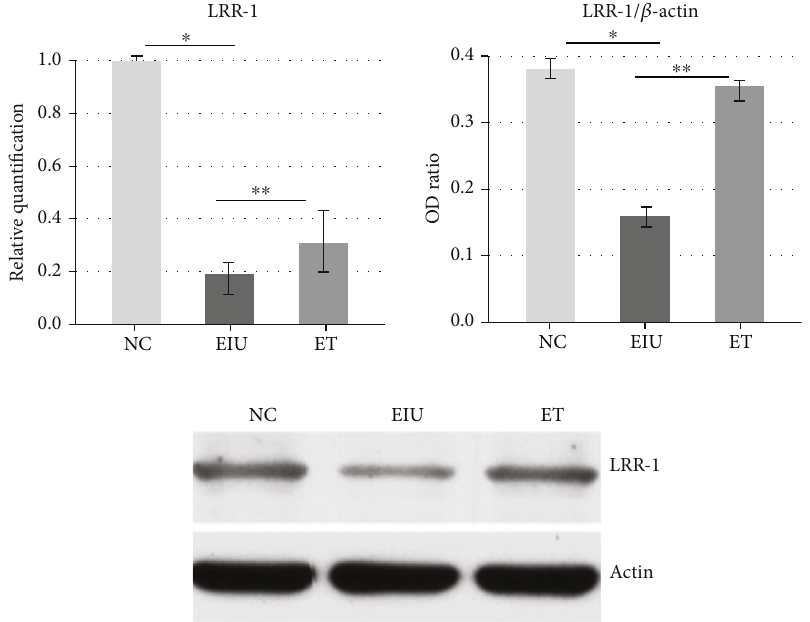
Figure 6: Real-time PCR and Western blot of LRR-1 in ICB. Both mRNA and protein expression of LRR-1 in the EIU group were lower than that in the NC group ( ∗ P < 0 : 05 ) and ET group (the mRNA expression of LRR-1: F = 348 : 862 , ∗∗ P < 0 : 05 ; the protein expression of LRR-1: F = 388 : 500 , ∗∗ P < 0 : 05 ). All data shown as mean ± standard deviation from ten independent